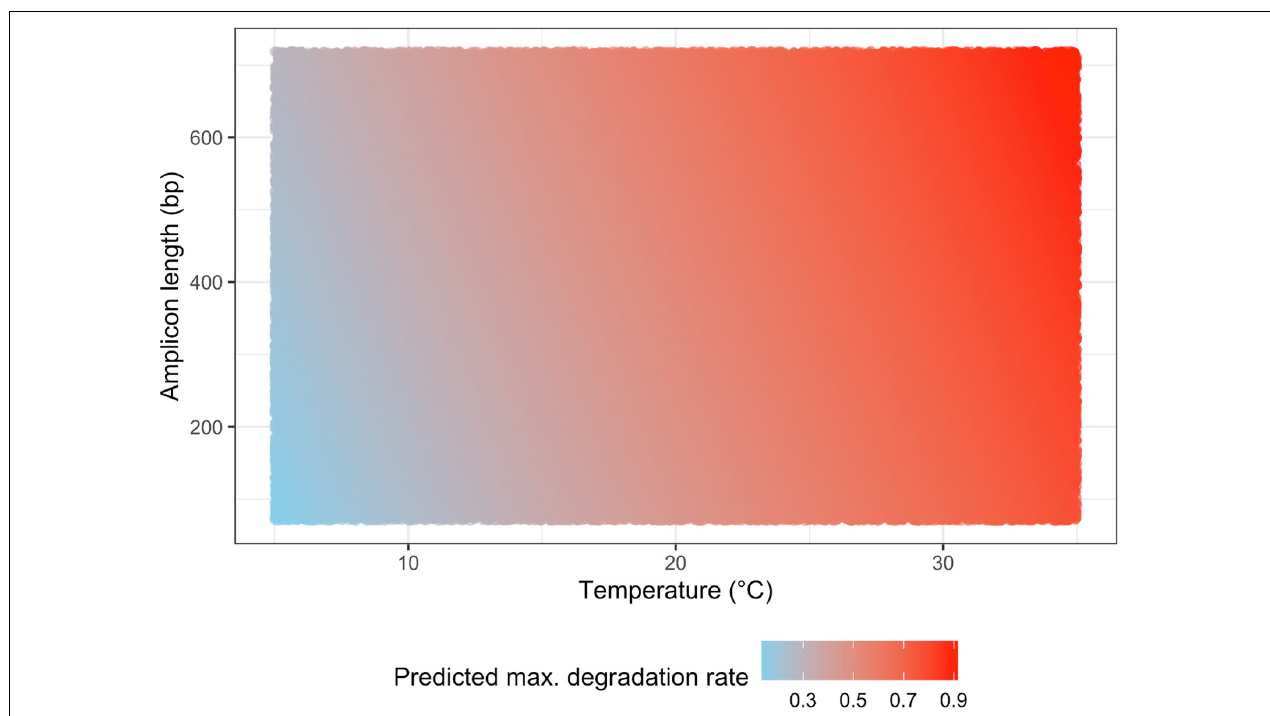
FIGURE 3 | The simulation result for predicting eDNA degradation rate on the matrix of water temperature and amplicon